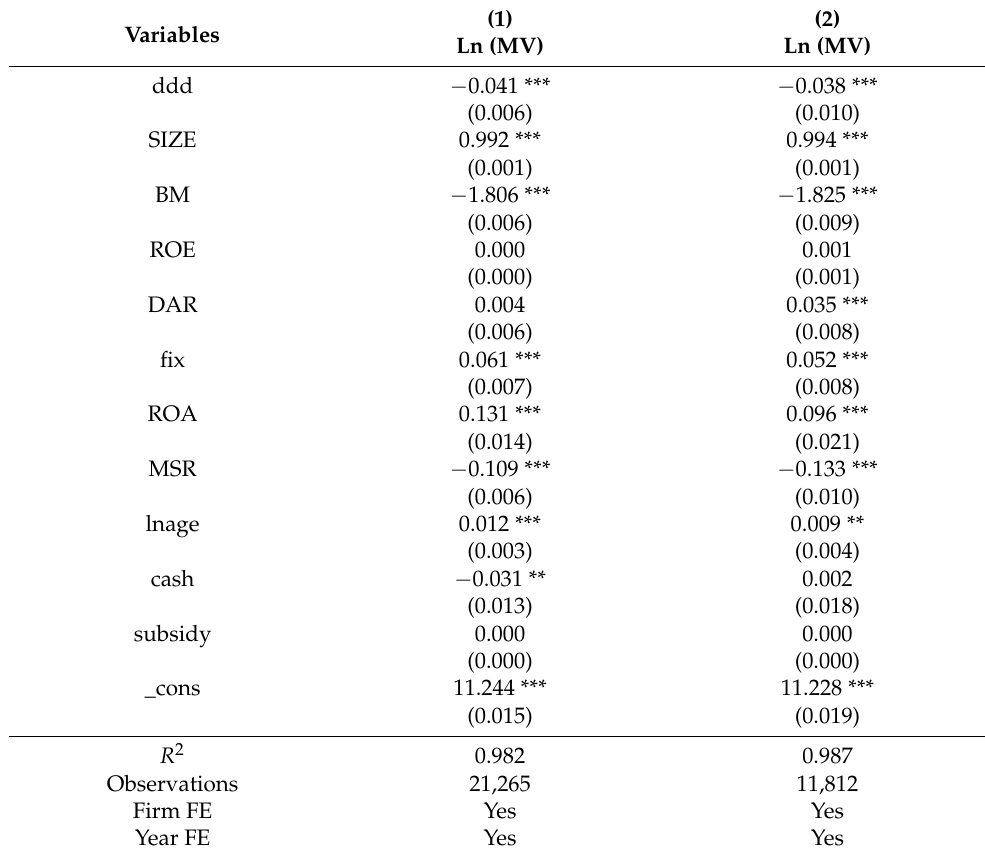
Table 11. Heterogeneous analysis of the different